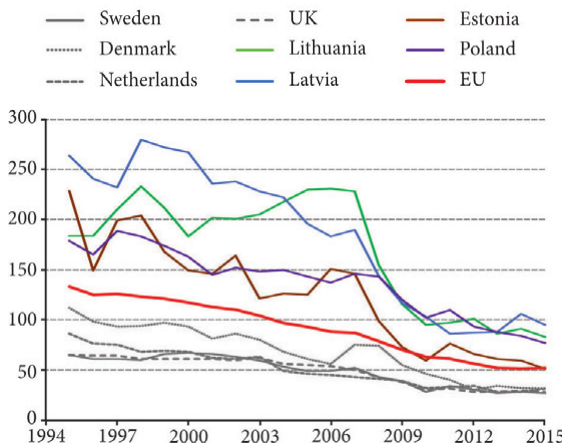
Fig. 1. Road fatalities per 1 million population according to the data of 2016 from the European Road Safety Observatory (ERSO 2016a)